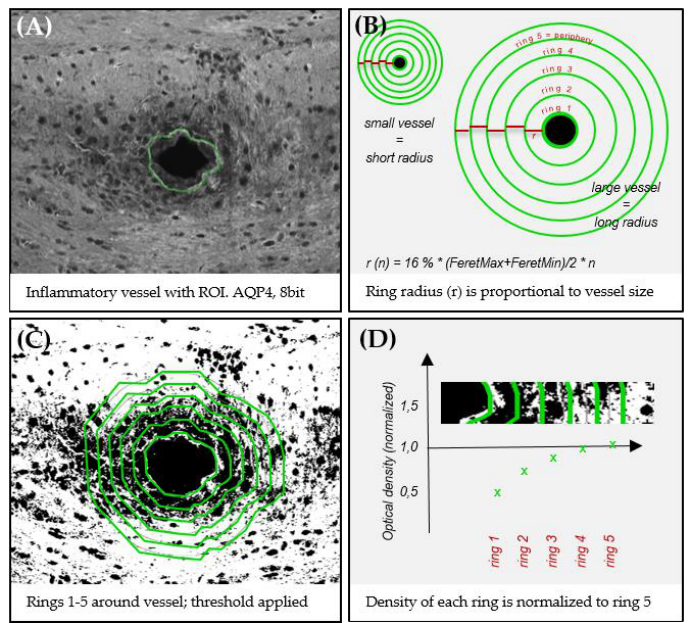
Figure A1. Applied quantification approach for focal perivascular optical density measurements. ( A ) The border of a vessel is manually marked as ROI. ( B , C ) Five concentric rings are created around a vessel to specify 5 distinct areas, while ring 1 represents the vessel’s immediate vicinity and ring 5 its outermost peripheral part. The immunoreactivity within each ring is then quantified by densitometry (see materials & methods). To compensate for differently sized vessels, the ring radius (r) 1 is set to 16% of the mean feret diameter (maximum feret + minimum feret/2) of its vessel. Subsequent rings sizes are calculated by 𝑟 (𝑛) = 𝑛 ∗ 𝑟𝑎𝑑𝑖𝑢𝑠 1 . ( D ) To compensate for different baseline immunoreactivities in between different slides, each measurement of ring 1–4 is normalized to ring 5 of the same vessel.